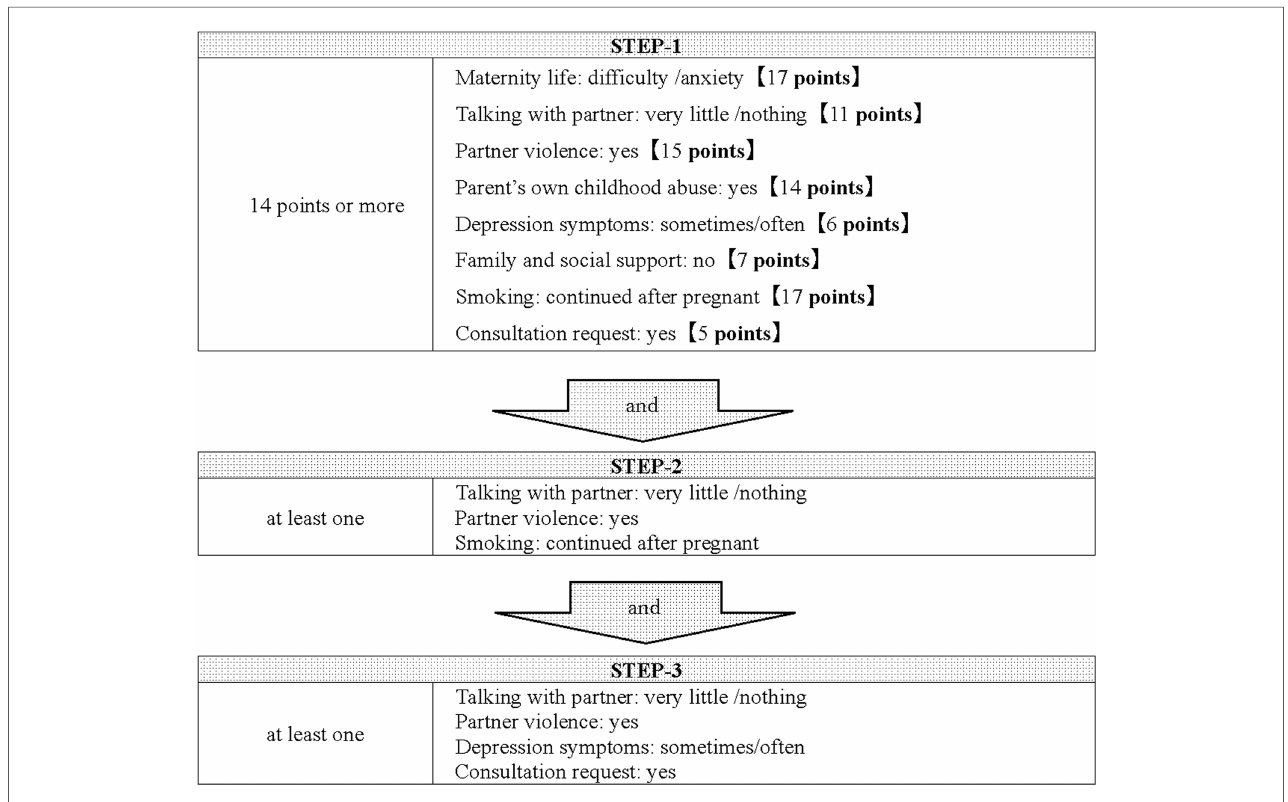
FIGURE 3 The screening tool used during the second trimester. Pregnant women with score of 14 points or more were selected as STEP-1. Then, pregnant women are narrowed down as STEP 2 and 3 according to the items on the interview sheet during the second